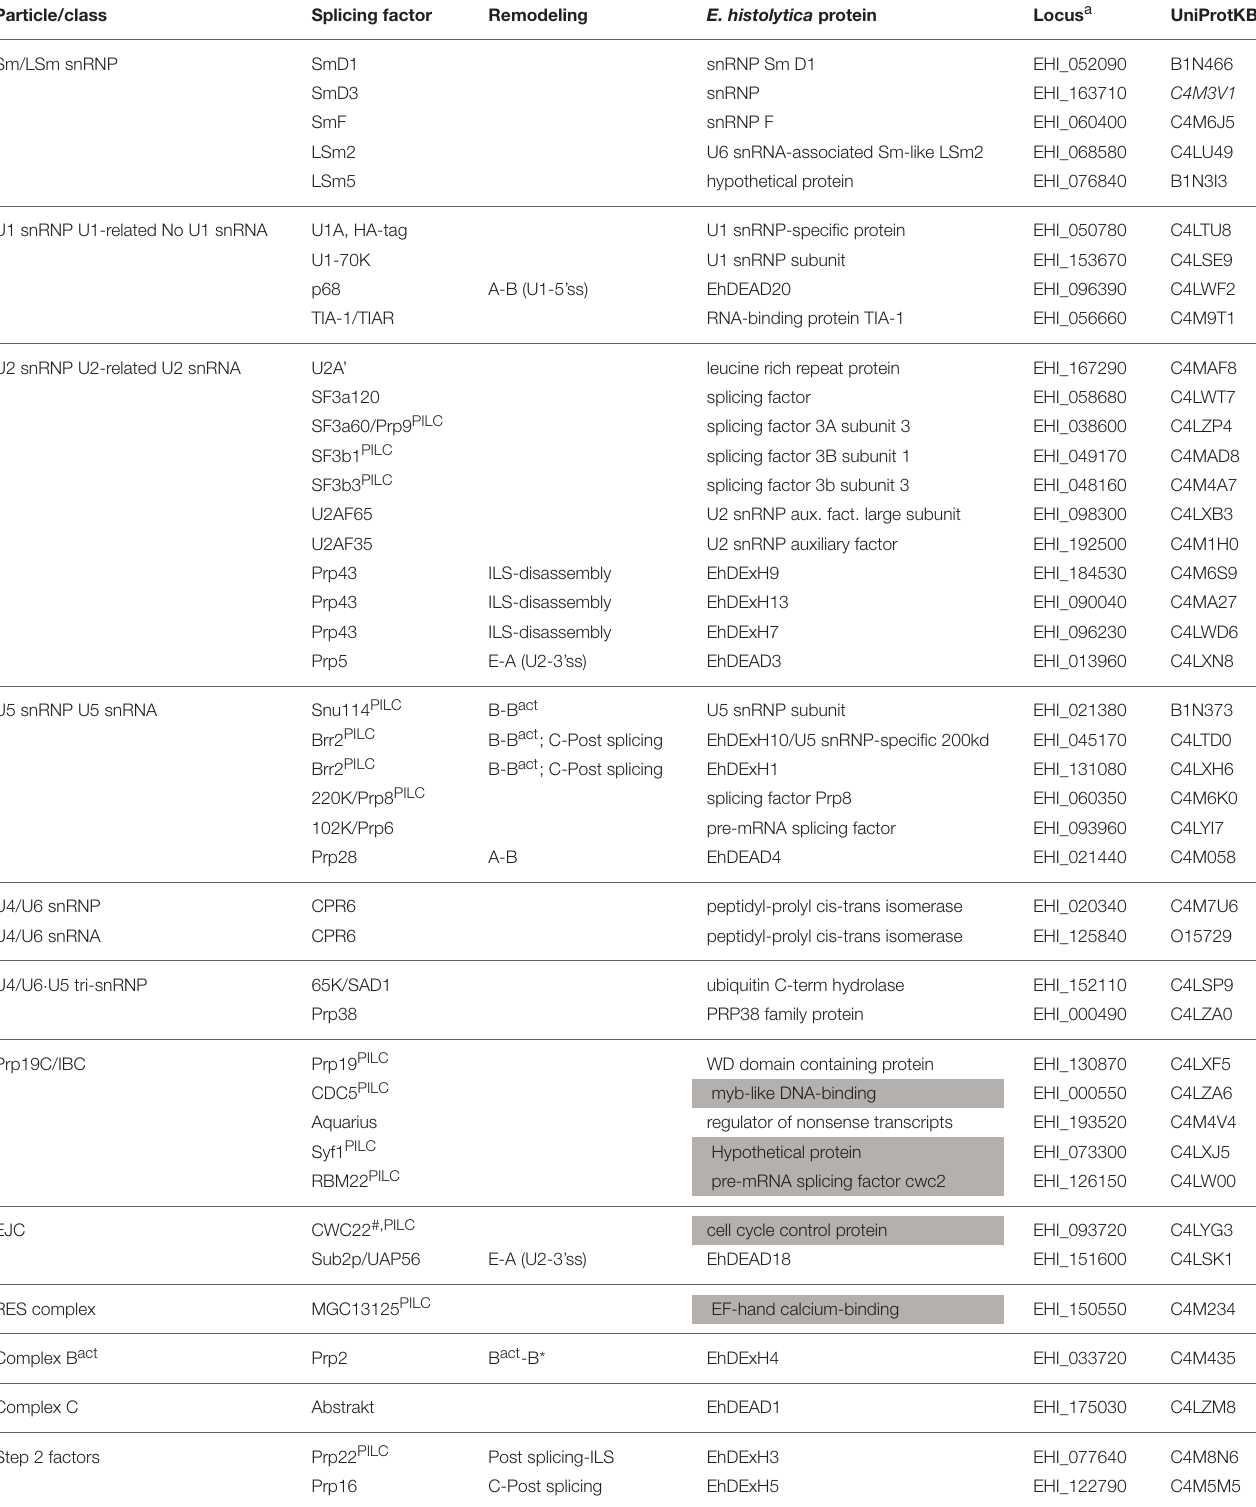
TABLE 1 | Comparison of splicing factors in Entamoeba histolytica vs. human and